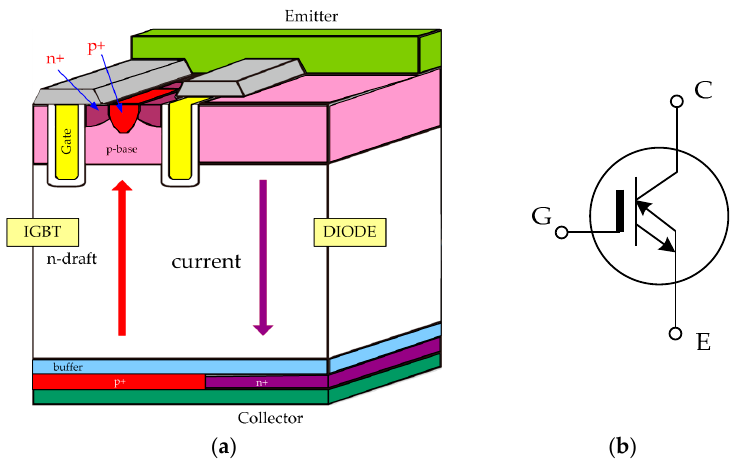
Figure 1. The diagram of Reverse Conducting-Insulated Gate Bipolar Transistor (RC-IGBT): ( a ) The internal structure; ( b ) the electrical symbol.